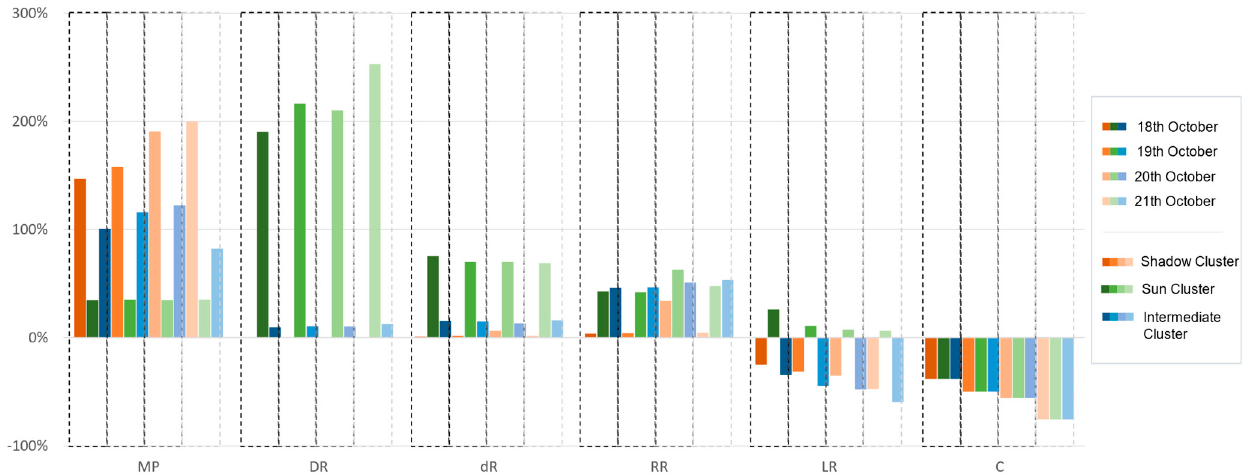
Figure 18. Graph of comparison between the objective and subjective thermal sensations.